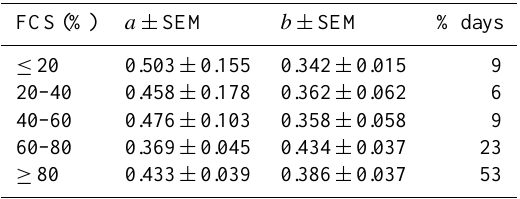
Table 3. Coefficients a and b between 1992 and 1996 for five FCS intervals.